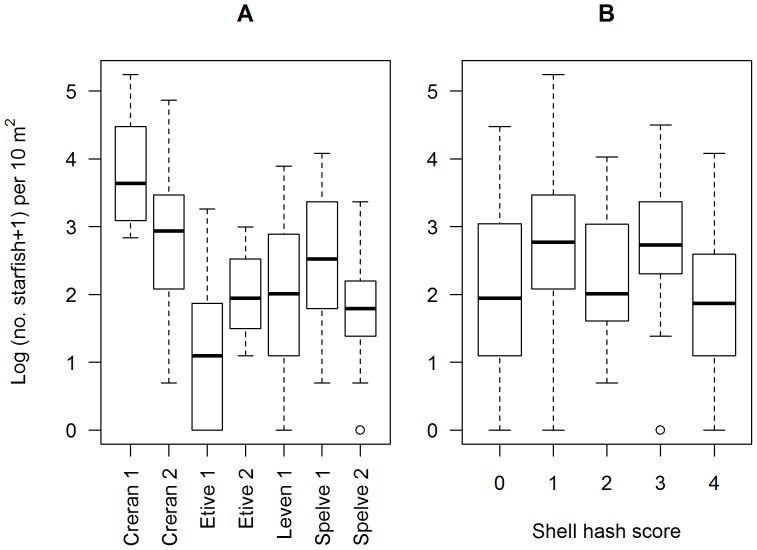
The relationship between log (number of starfish +1) per 10 m2 in different lochs (A) and compared with shell-hash score (B).The median abundance is indicated by the horizontal line within the box (interquartile range), upper and lower serifs represent the upper and lower adjacent values.